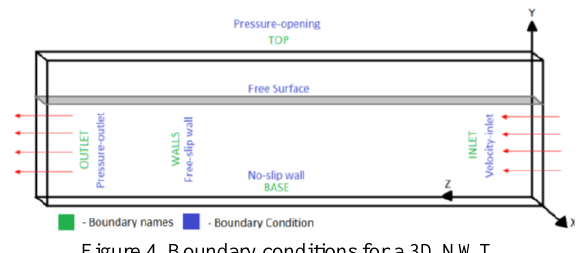
Figure 4. Boundary conditions for a 3D